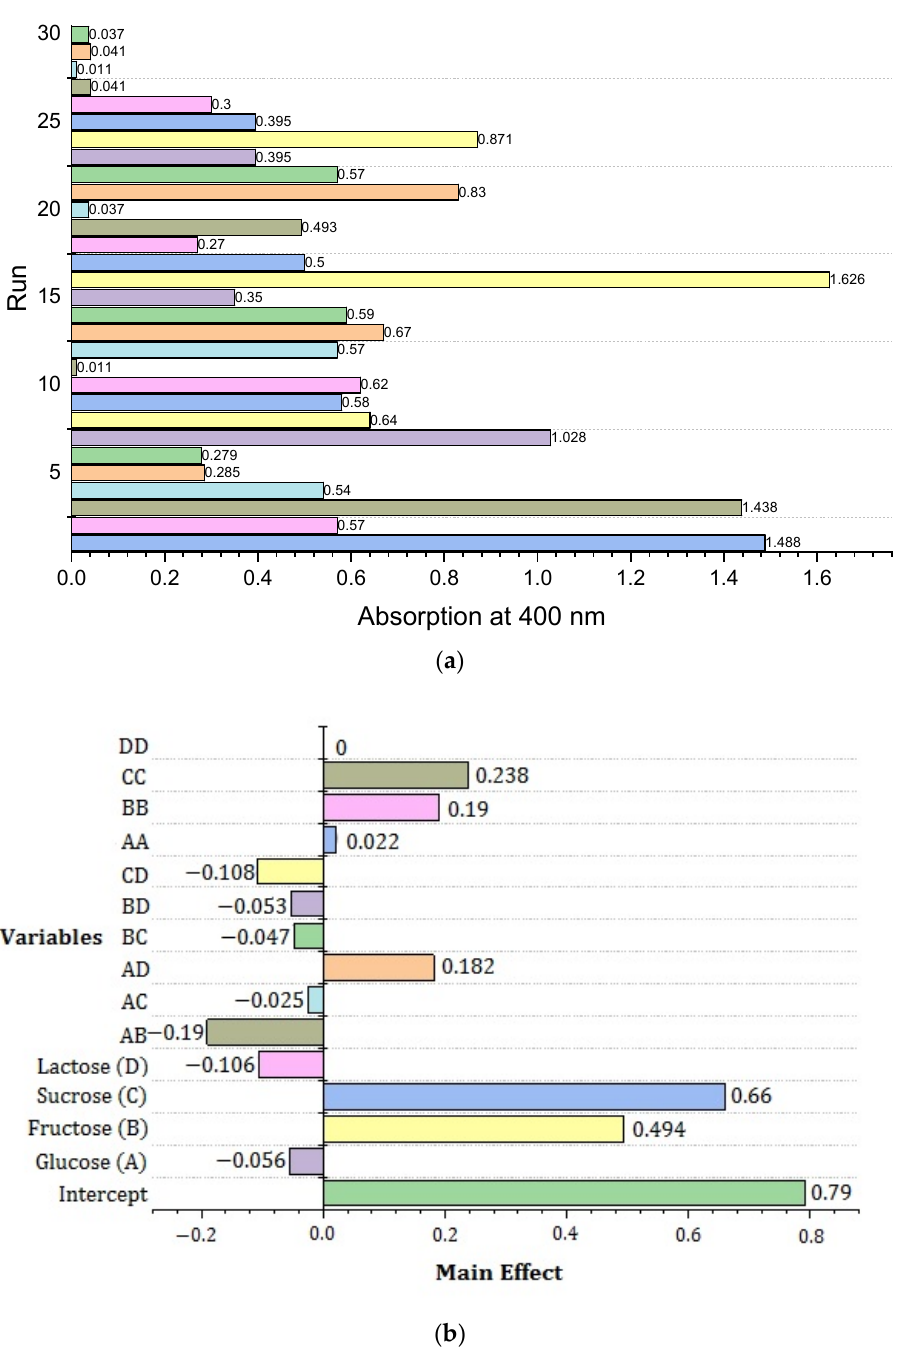
Figure 2. ( a ) Pareto chart illustration of assays of experiments with response variable. ( b ) The significance of the variables affecting AgNPs is represented by a Pareto chart, which shows positive and negative effects.